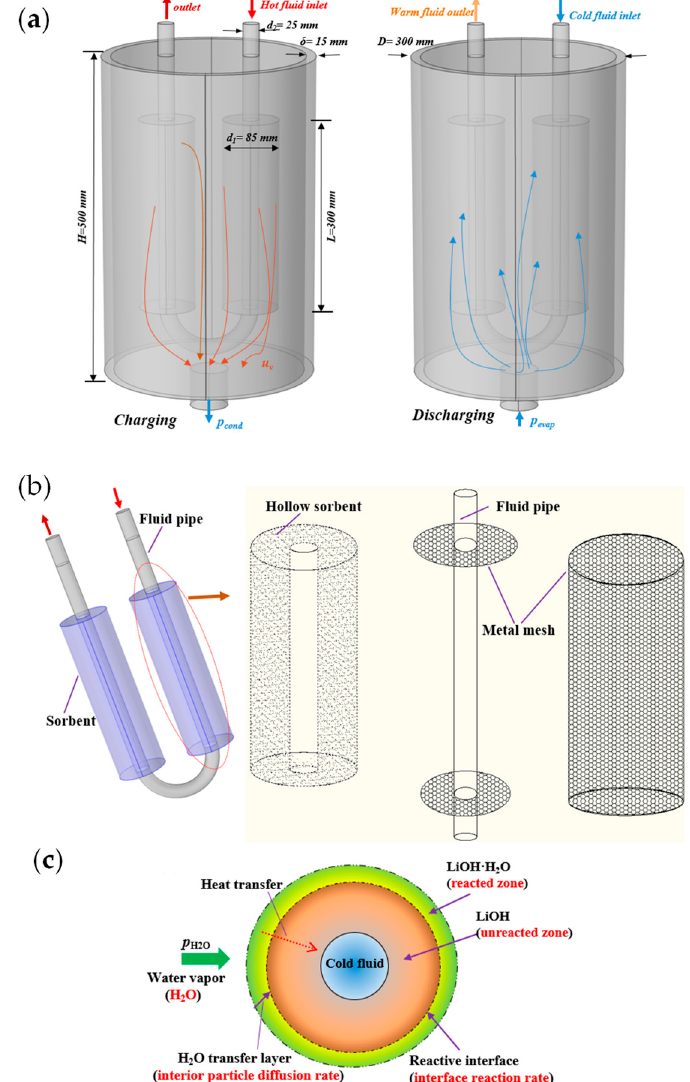
Figure 28. Reactor geometry model in charging and discharging phase for simulations: ( a ) Reactor geometry model in charging and discharging phase for simulations; ( b ) structures of reaction bed unit; ( c ) schematic diagram of hydration reaction model from top view [268]: Reprinted with permission from Ref. [268] Copyright © 2020 Elsevier Ltd. All rights reserved.